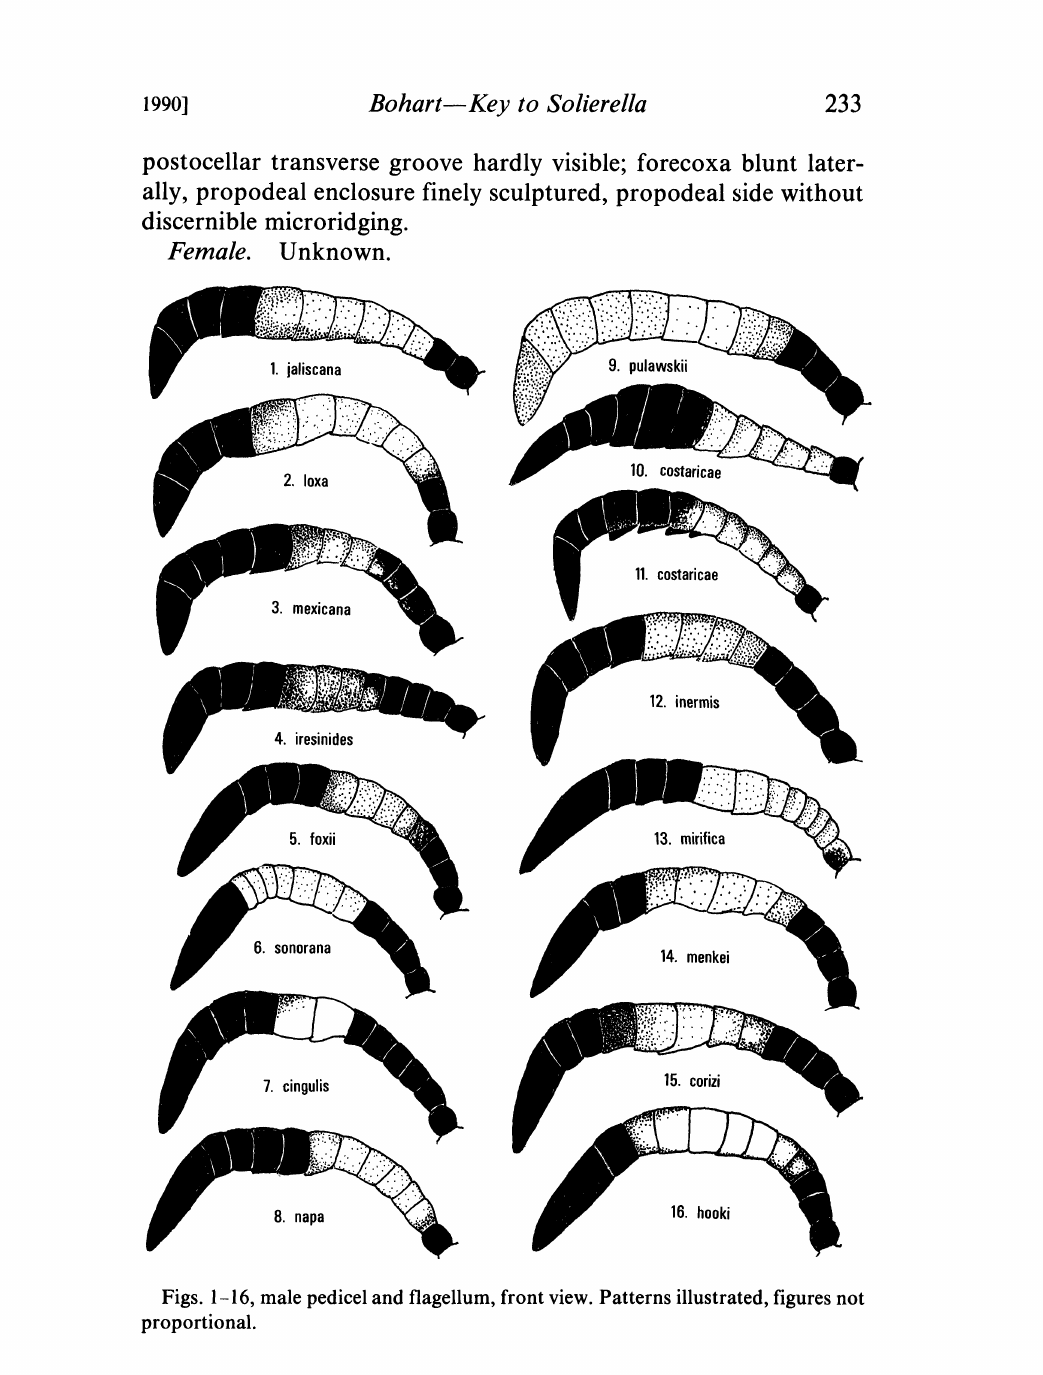
Figs. 1-16, male pedicel and flagellum, front view. Patterns illustrated, figures not